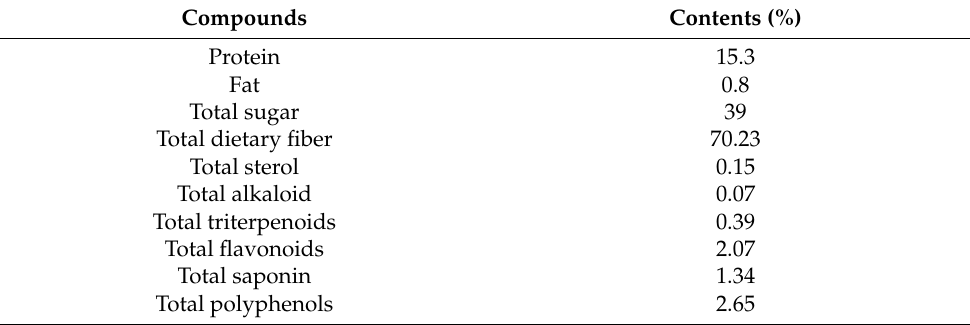
Table 1. The general nutritional composition of IHS.